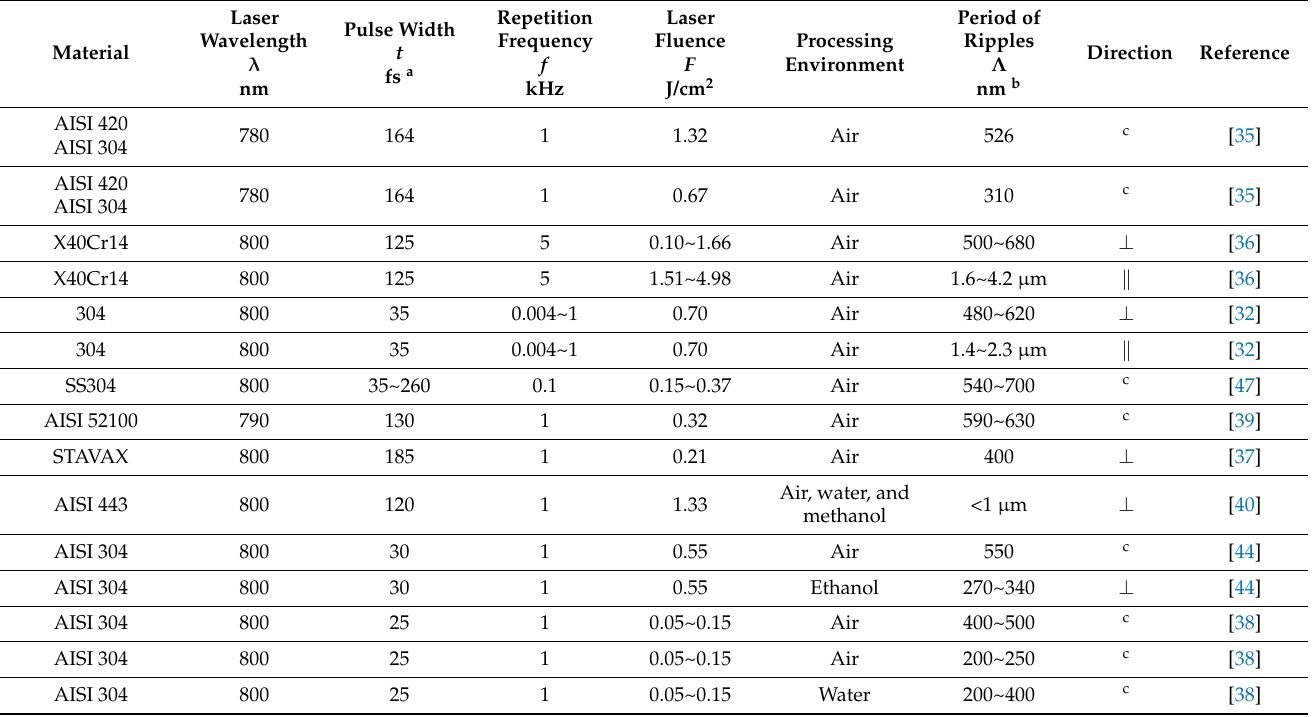
Table 1. Main test parameters and typical structures of